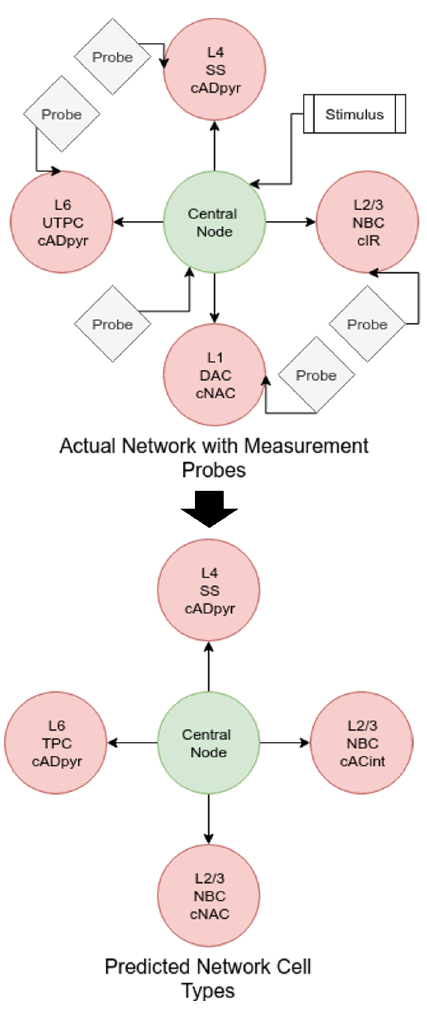
Figure 11. Sample reconstruction of network. Table 5. Performance of 4-leaf star topology